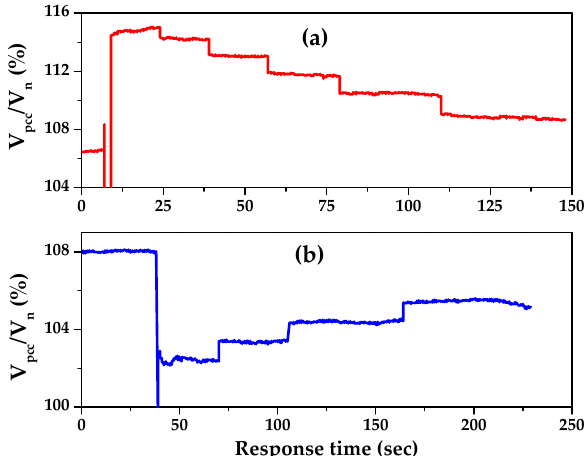
Figure 3. Functionality of the tap-changer in case of ( a ) voltage drop, and ( b ) voltage rise.